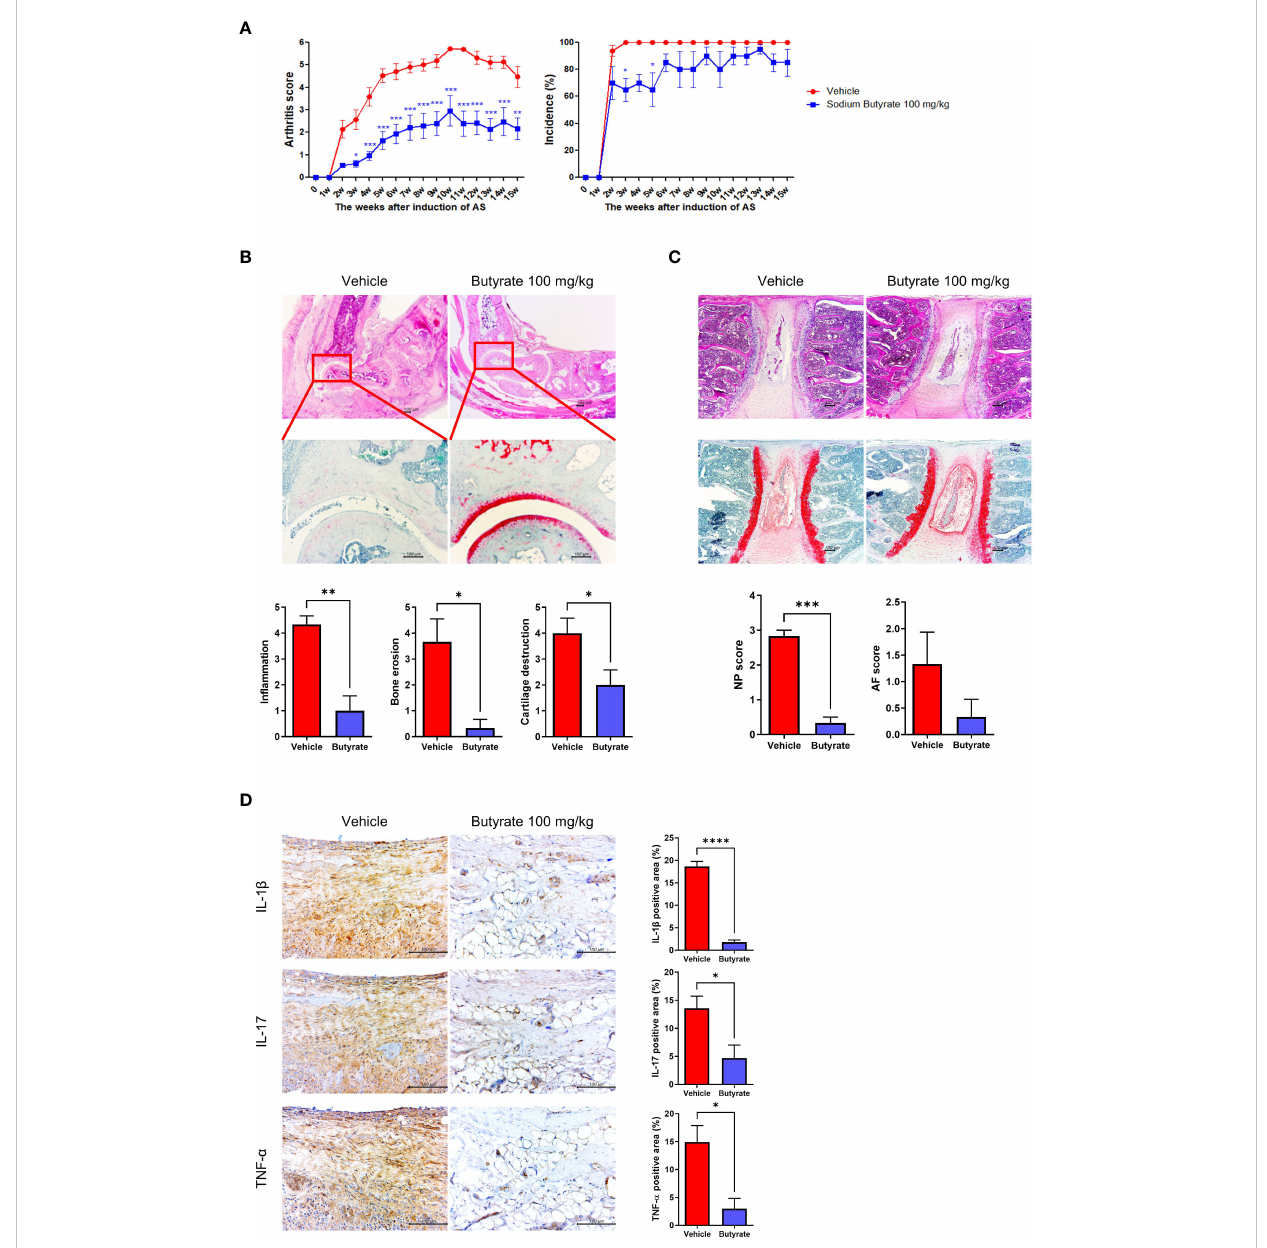
FIGURE 5 Effects of butyrate treatment on curdlan-induced SpA mice. SKG mice were injected with 3 mg of curdlan through intraperitoneal and oral administration. One week later, sodium butyrate (100 mg/kg) was administered orally once a day for 14 weeks. (A) Arthritis score and incidence were monitored by observation twice a week. (B, C) At 15 weeks post curdlan injection, joint and spine tissue samples were collected from all groups. Histopathology was evaluated for H&E and Safranin O staining. In fl ammation, bone erosion, cartilage destruction, and nucleus pulposus (NP) and annulus fi brosus (AF) scores were assessed in both groups. (D) Synovial tissues in joints were immunohistochemically stained for IL-1 b , IL-17, and TNF- a . Positive area (%) was analyzed with the color deconvolution tool in ImageJ. * P < 0.05, ** P < 0.01, *** P < 0.001 and **** P <